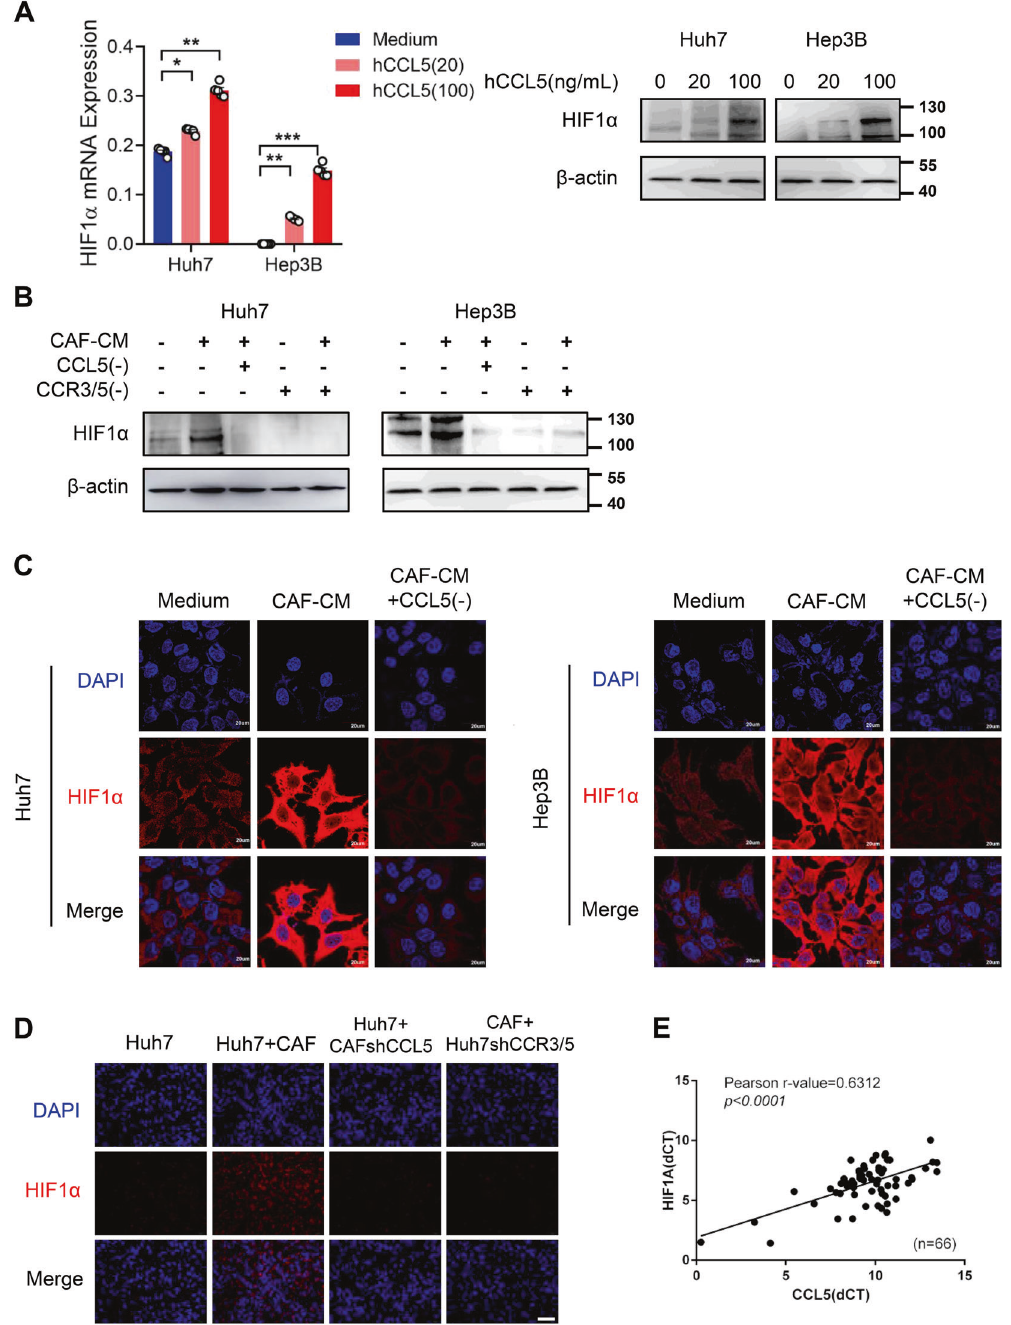
Fig. 5 CCL5 derived from CAFs upregulates HIF1 α in liver cancer cells. A The expression of HIF1 α in Huh7 and Hep3B cells treated with hCCL5 (20 ng/ml and 100 ng/ml) was detected by RT-PCR and western blotting. B The protein expression of HIF1 α in Huh7 and Hep3B cells treated with the CM of CAFs, a CCL5 neutralizing antibody or CCR3/CCR5 antagonists was assessed using western blotting. C HIF1 α expression of Huh7 and Hep3B cells were tested by immuno fl uorescence staining and photographed under a confocal microscopy when treated with CAF-CM or CAF-CM treated with a CCL5 neutralizing antibody. Scale bar: 20 μ m. D Immuno fl uorescence staining of HIF1 α protein was detected in four groups of tumor samples including Huh7 cells, Huh7 cells co-injected with CAFs, Huh7 cells co-injected with shCCL5 CAFs and shCCR3/5 Huh7 cells co-injected with CAFs. Scale bar: 100 μ m. E Pearson correlation analysis showed that HIF1A was positively correlated with the expression of CCL5 in 66 liver cancer samples ( r = 0.6312, p < 0.0001). N = 5 per group. Mean ± SD, * p < 0.05, * *p < 0.01, *** p < 0.001, compared with the tumor control study, we indicated that CCL5 was a crucial mediator interacting metastasis by affecting angiogenesis and tumor immunity [12]. A CAFs and HCC cells. CCL5 inhibited the ubiquitination degradation previous study had shown that CAFs were closely related to the of HIF1 α and up-regulated the downstream ZEB1 to promote liver invasion and metastasis of HCC cells [13, 14], but the mechanism cancer metastasis (Fig. 7G). To address this issue, we proved that of CAFs in regulating HCC metastasis was not fully clari fi ed. In this